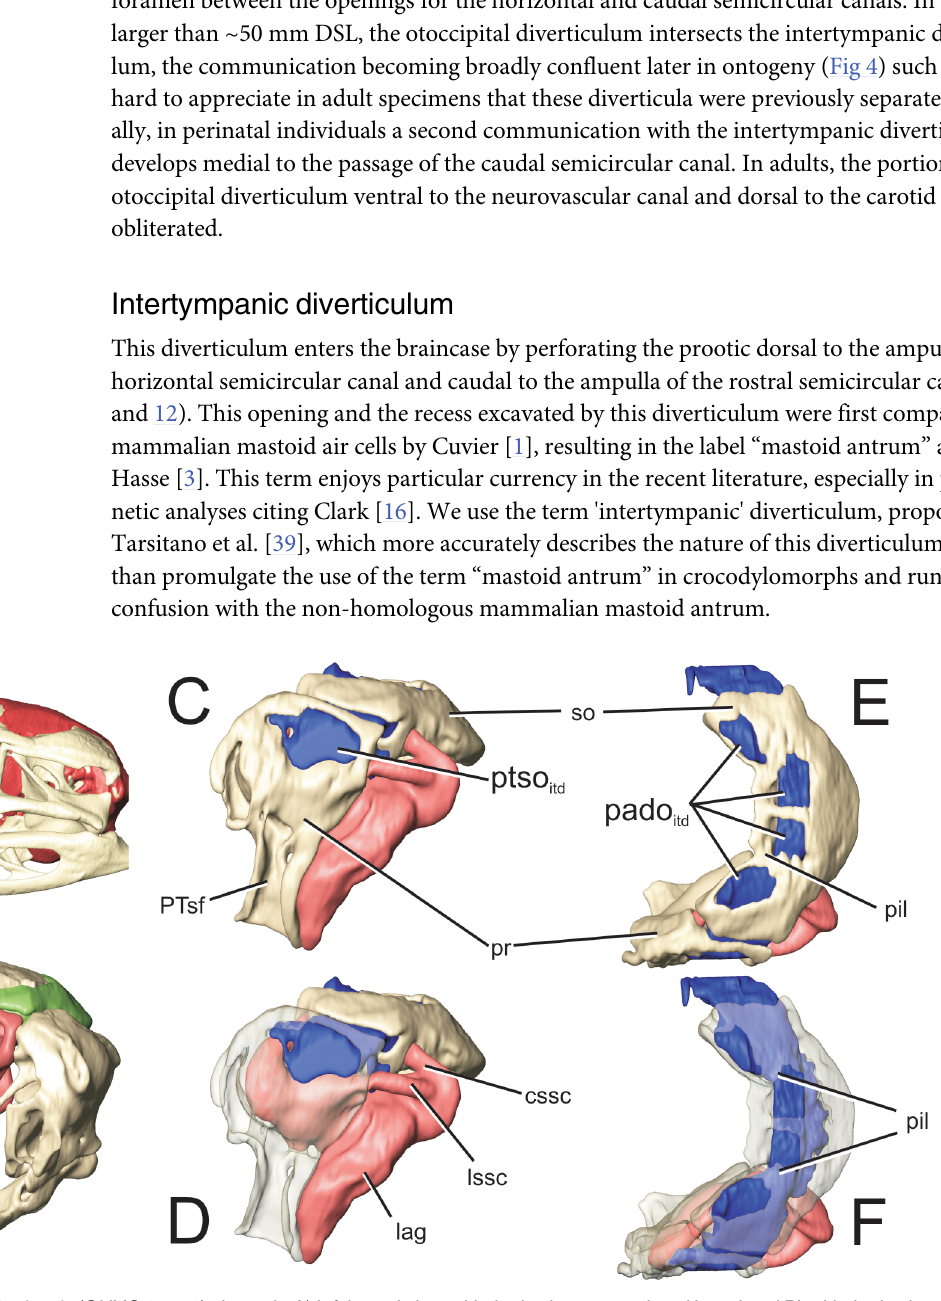
Fig 12. Perinatal Alligator mississippiensis (OUVC 10606) shown in A) left lateral view with the braincase rendered in red and B) with the braincase isolated and the prootic rendered in red and the supraoccipital rendered in green. Isolated prootic and supraoccipital with endosseous labyrinth C) in left lateral view and D) with the left prootic rendered transparent. Isolated prootic and supraoccipital E) in dorsal view and F) with the supraoccipital and left prootic rendered transparent. Labyrinth rendered in pink, intertympanic diverticulum rendered in blue. cssc, caudal semicircular canal; lag , lagena; lssc , lateral semicircular canal; pado otd , communicating ostia between parietal diverticula and intertympanic diverticulum; pil , osseous pillar; pr , prootic; PTsf , fossa for pharyngotympanic sinus; ptso itd , communicating ostium between pharyngotympanic sinus and intertympanic diverticulum; so ,